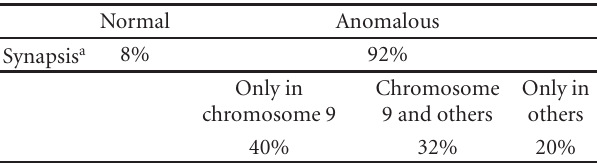
analyzed. Table 2: Values obtained for asynapsis in pachytene cells in the heterochromatin polymorphism